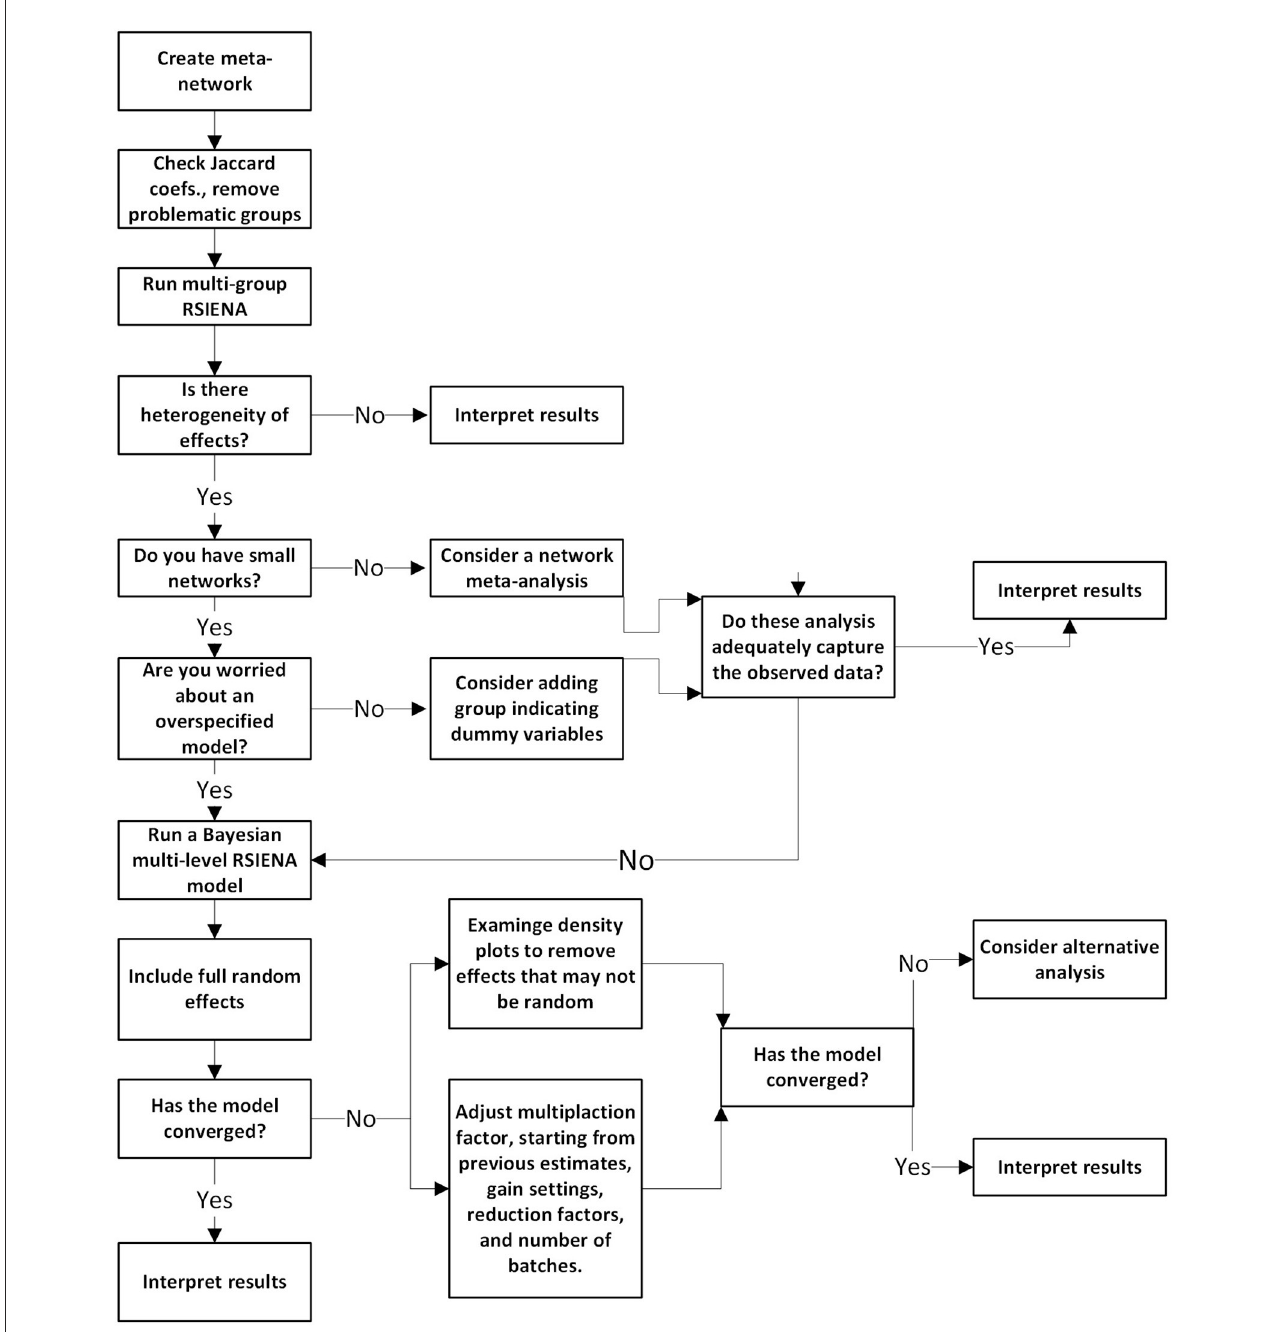
FIGURE5 Decision tree format for modeling evolution of network dynamics for multiple